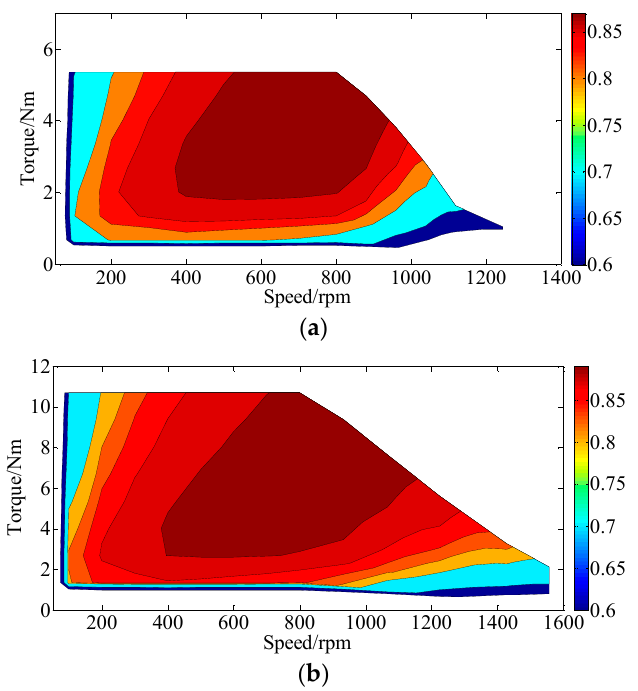
Figure 16. Efficiency maps. ( a ) External DC field current control. ( b ) DC bias current control.